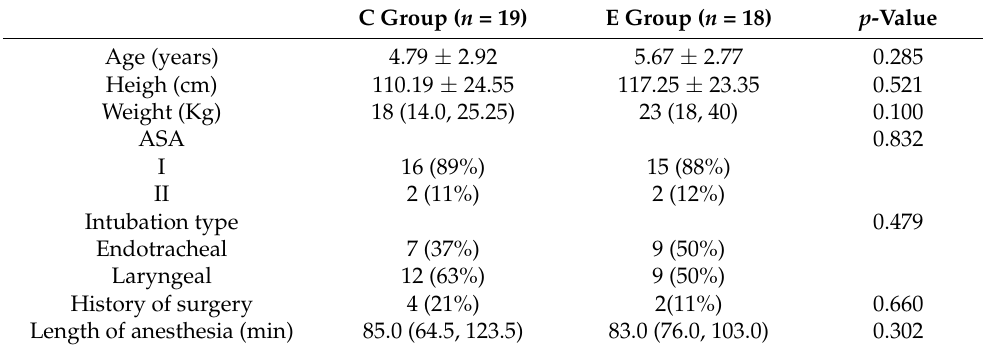
Table 1. Baseline characteristics of two